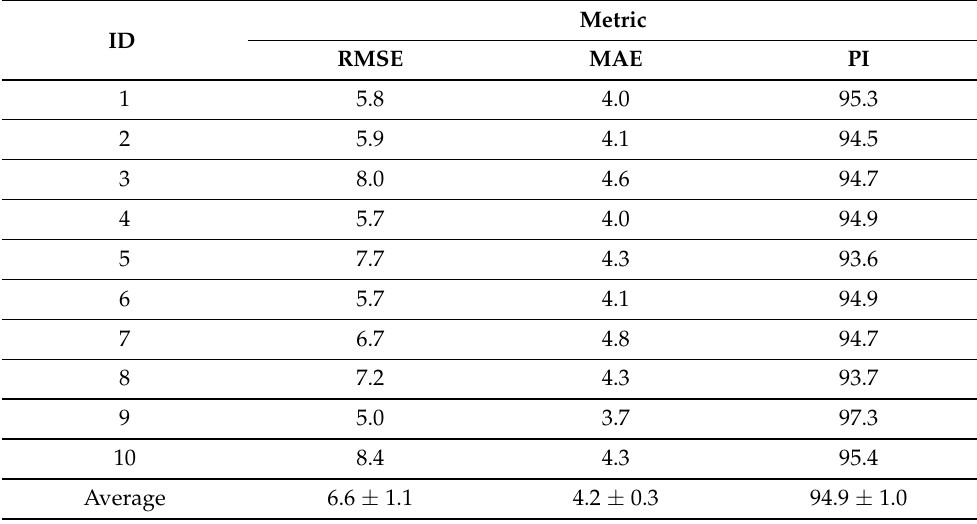
Table A1. Performance metrics for neural network on validation set: The parameters of the meal detection and estimation framework are selected based on performance of the model on the validation set. This is based on last 20% of the training data in order to attain the predictive accuracy and prediction interval